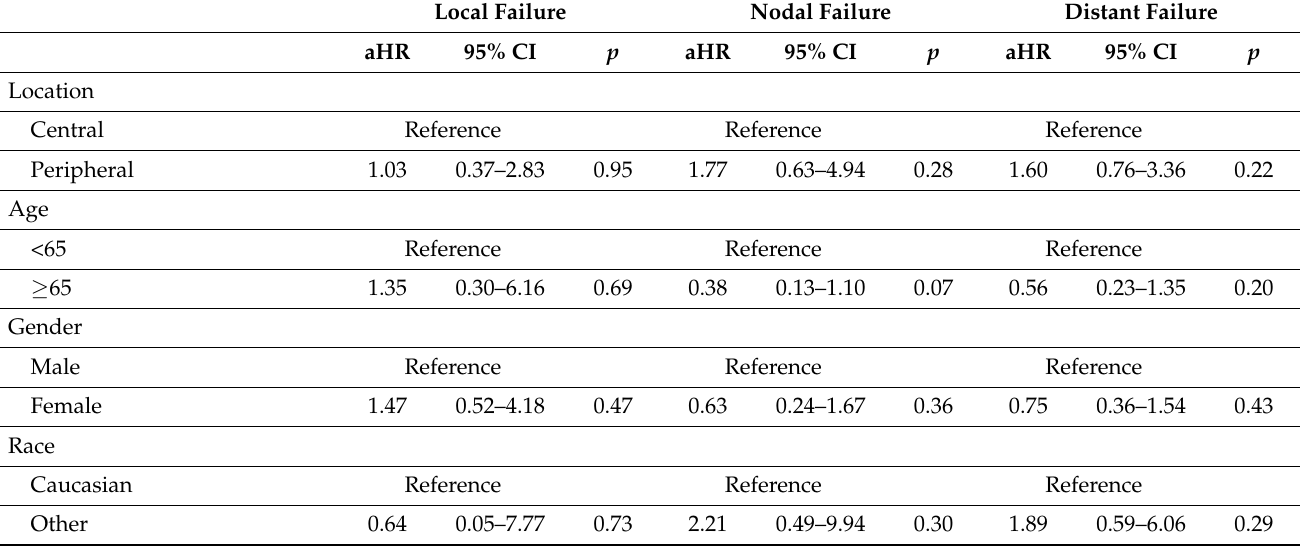
Figure 1. Kaplan–Meier plots for ( A ) overall survival and ( B ) progression-free survival among single- and five-fraction SBRT cohorts. Table 3. Multivariable competing risk regression for local, nodal, and distant failure